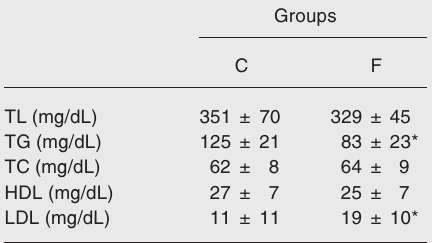
Table 2. Effect of diet on serum